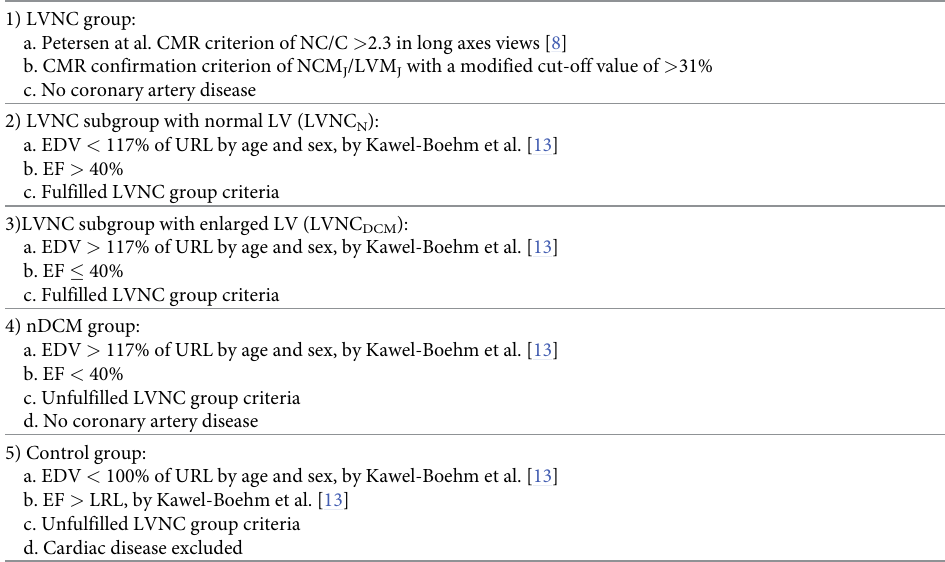
Table 2. Left ventricular noncompaction (LVNC), nonischemic dilative cardiomyopathy (nDCM) and control group inclusion